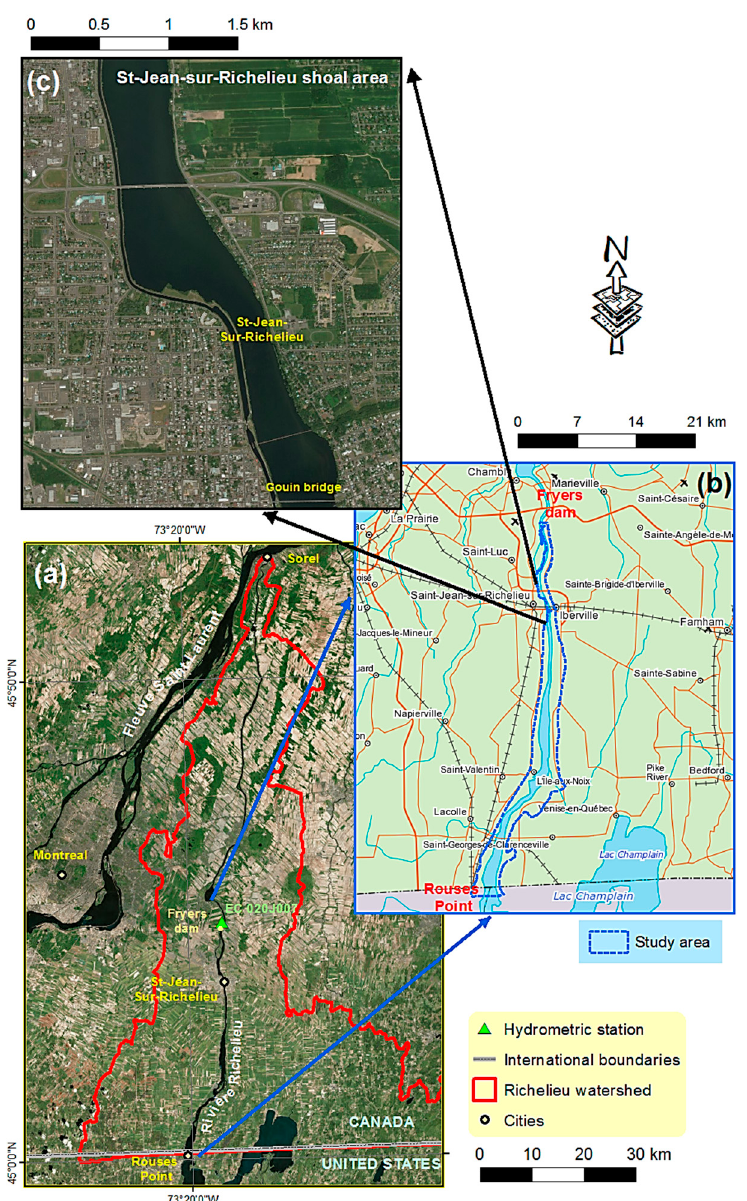
Figure 1. The Richelieu River watershed ( a ), the study area ( b ), and the shoal area at Saint-Jean-Sur- Richelieu ( c